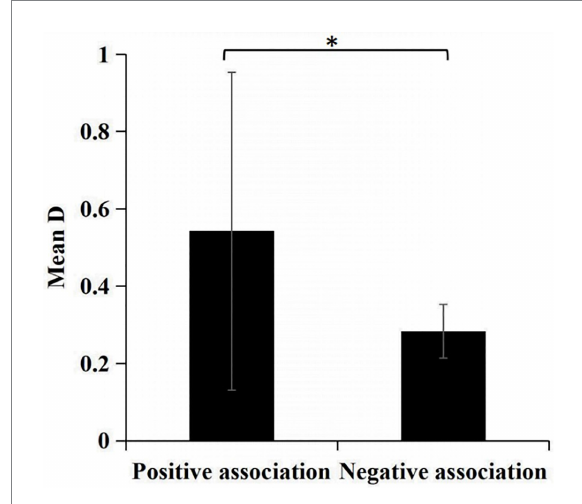
FIGURE 3 Comparison of the response sensitivity of negative and positive association in GNAT. Note: ** p < 0.01, *** p < 0.001.